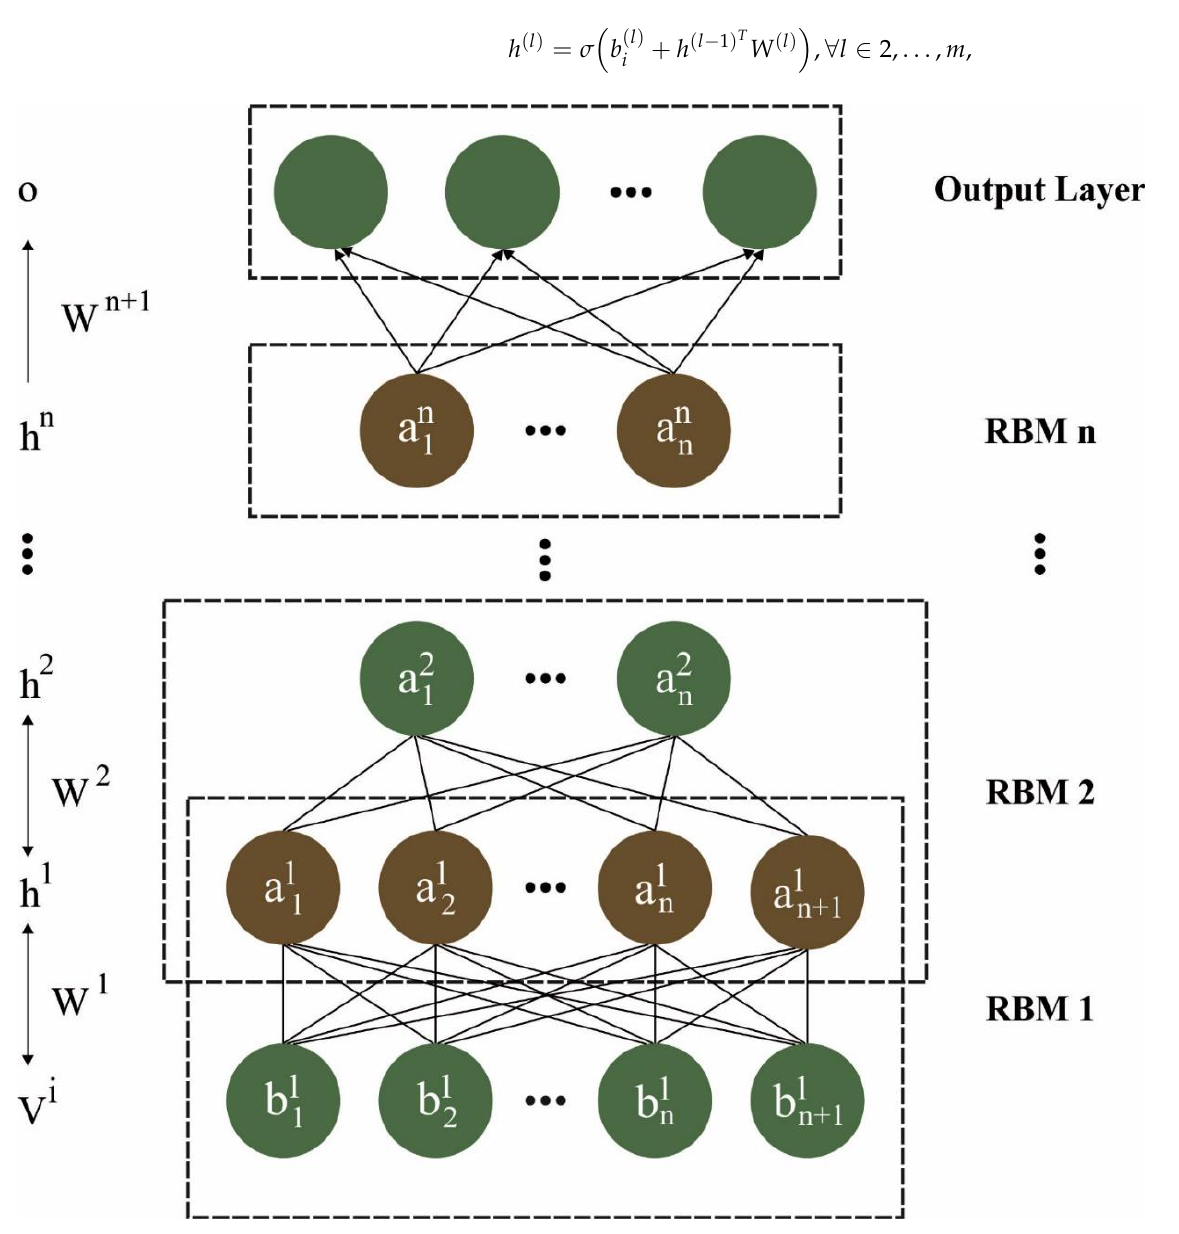
Figure 2. Structure of DBN.